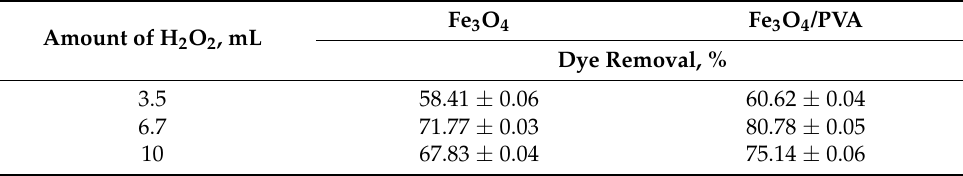
Table 2. Dye removal percentage values for composite at different amounts of hydrogen peroxide (H 2 O 2 ).